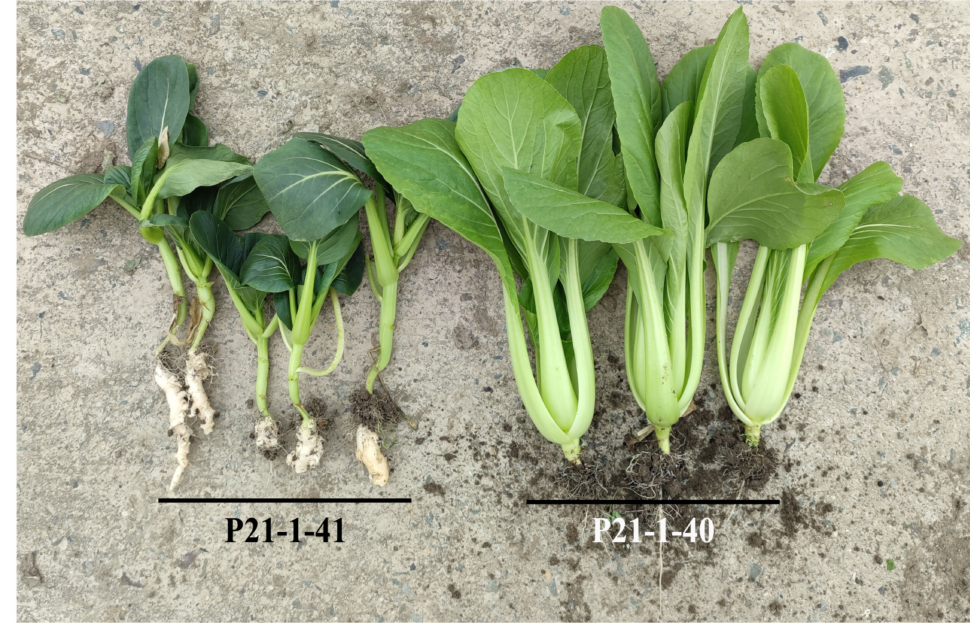
Figure 4. Phenotypes of clubroot disease in resistant variety P21-1-40 and susceptible variety